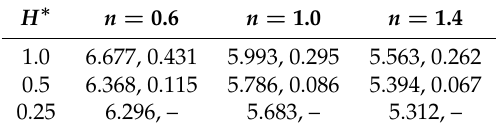
Figure 10. Instantaneous temperature contours at Re = 100, Pr = 1.0, H 0 = 1.0 and n = 0.6. ( a ) 0 T , ( b ) T /4, ( c ) T /2 and ( d ) 3 T /4. Table 5. Time-averaged Nusselt number ( Nu ) and its amplitude ( ∆ Nu ) for forced convection heat transfer from an oscillating cylinder to power-law fluids at Re = 100, Pr = 1.0, and f ∗ = 1.0. H ∗ n = 0.6 n = 1.0 n = 1.4